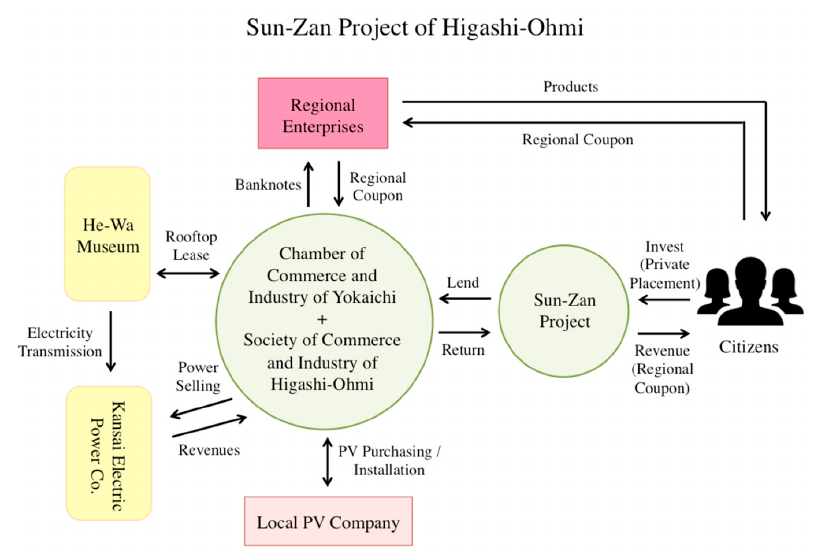
Figure 5. The Chamber of Commerce and Industry is the issuer of regional currency and the joint owner of the Citizens’ Co-Owned Power Plant. Source modified from Prefecture-Shiga, 2016, 2017; Yokaichi Chamber of Commerce and Industry (2016).